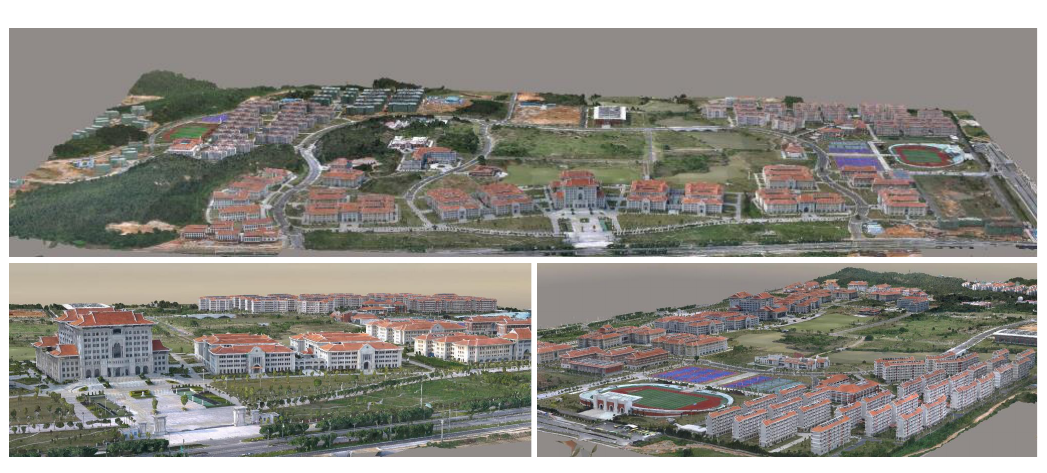
Figure 5. The generated 3D image-based point cloud of the Xiangan campus of Xiamen University.